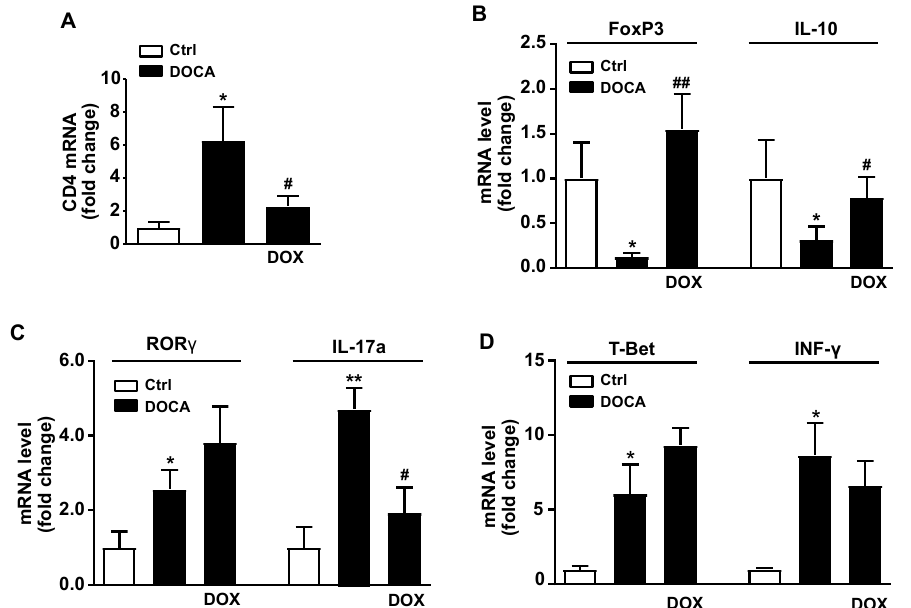
Figure 6. Effects of Doxycycline (DOX) on aortic T-cells infiltration. ( A ) Th (CD4) cells infiltration in aorta. ( B ) Regulatory T cells (Treg) infiltration in aorta quantified by proxy with FoxP3 and interleukin (IL)-10 mRNA levels. ( C ) Aortic T helper (Th)17 infiltration determined with mRNA levels of ROR γ and IL-17a. ( D ) Aortic Th1 (T-bet) infiltration and IFN- γ in control (Ctrl) and DOCA-salt rats. Data are represented as means ± sem ( n = 8). * p < 0.05, ** p < 0.01 versus Ctrl group; # p < 0.05, ## p < 0.01 versus DOCA-salt group.